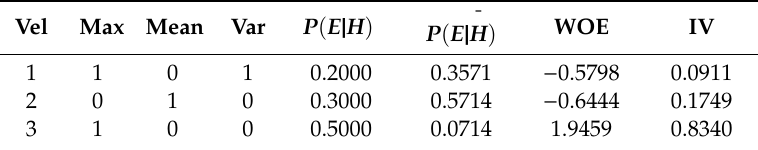
Table 6. Information value calculation during one open